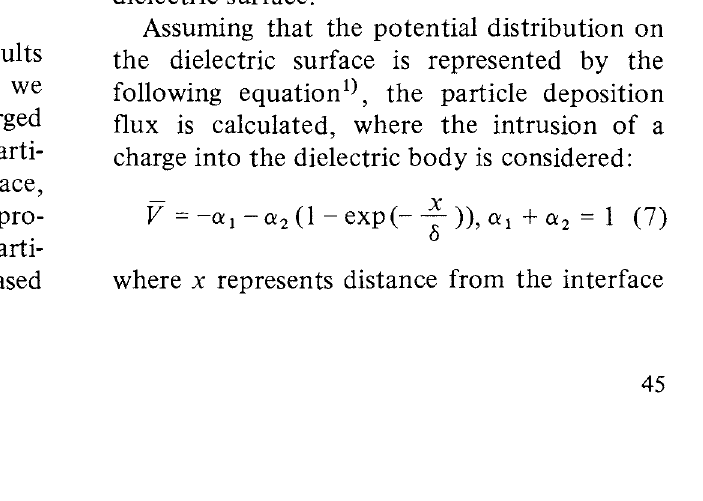
Fig. 11 Deposition flux distribution with particle charge equal to e